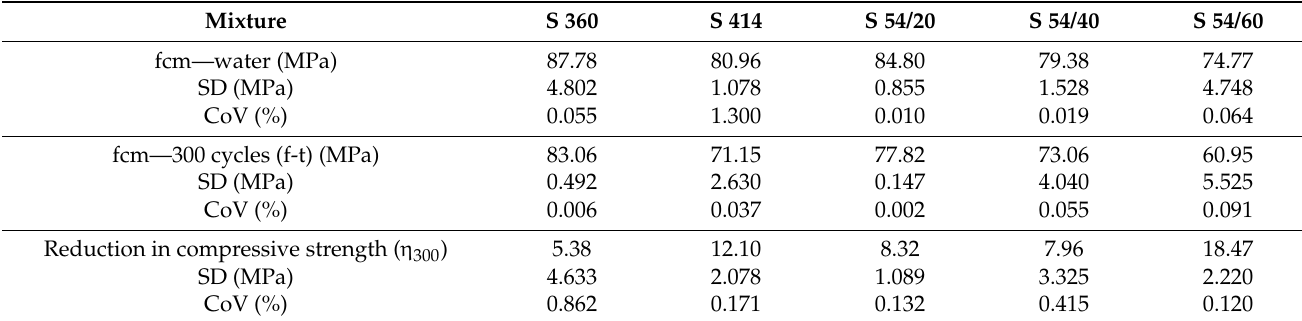
Table 6. The average compressive strengths, resistance losses after 300 freeze–thaw cycles [42], standard deviation and coefficient of variation.